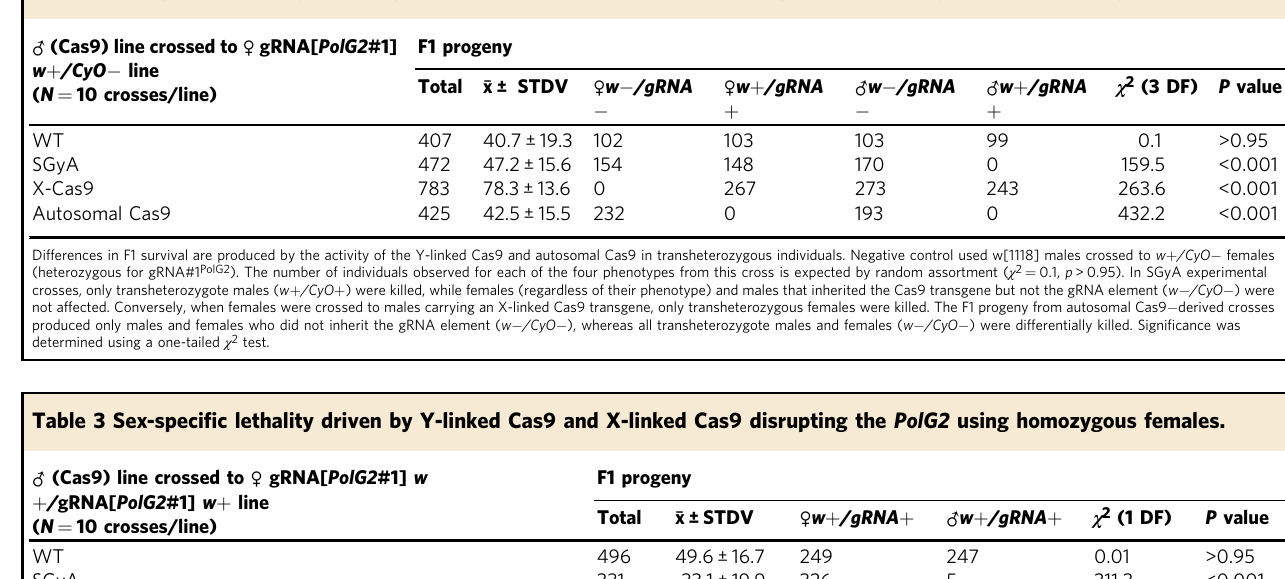
Table 2 Sex-speci fi c lethality driven by Y-linked Cas9 and X-linked Cas9 disrupting the PolG2 gene using heterozygous females. ♂ (Cas9) line crossed to ♀ gRNA[ PolG2 #1] w + /CyO − line ( N = 10 crosses/line)